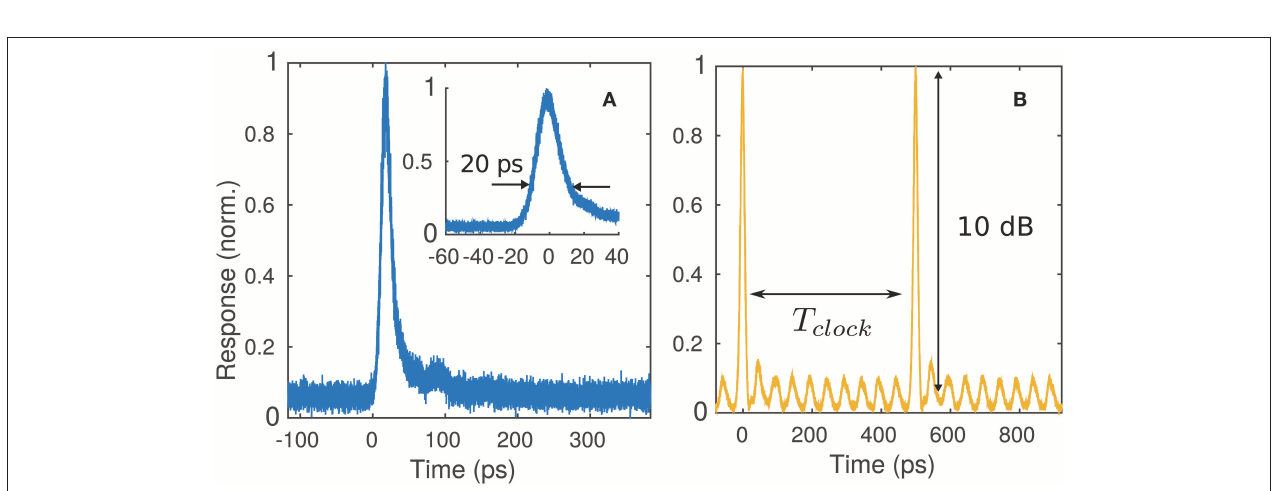
FIGURE 8 | Experimental set-up for all-optical sampling experiment. MLL, mode-locked laser; TL, tunable laser; OSC, RF synthesizer; MZM, Mach-Zehnder modulator; AOG, all-optical gate; BPF, bandpass filter; LN EDFA, low-noise EDFA; PD, photodiode; LPF, lowpass filter. The optical paths of the clock ( clk ) and the signal ( s ) are colored in red and blue,